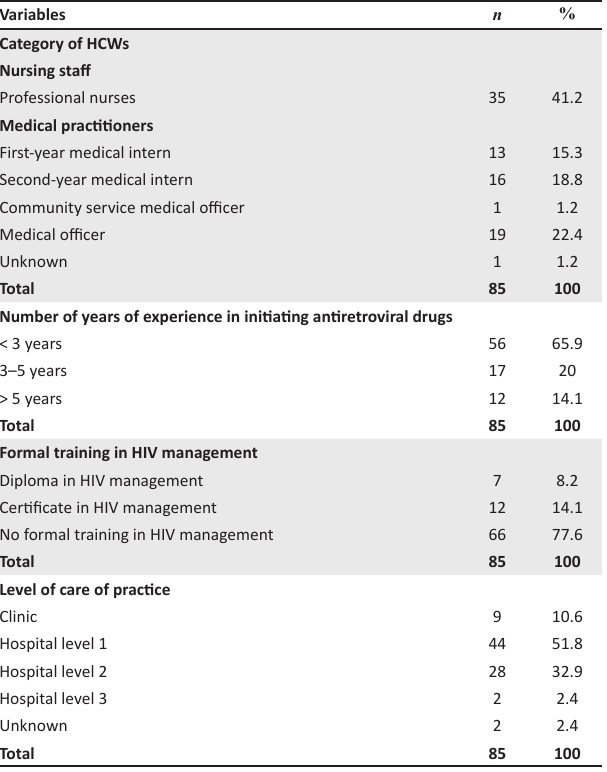
TABLE 2: Knowledge of cervical cancer screening guidelines or protocol compiled by different